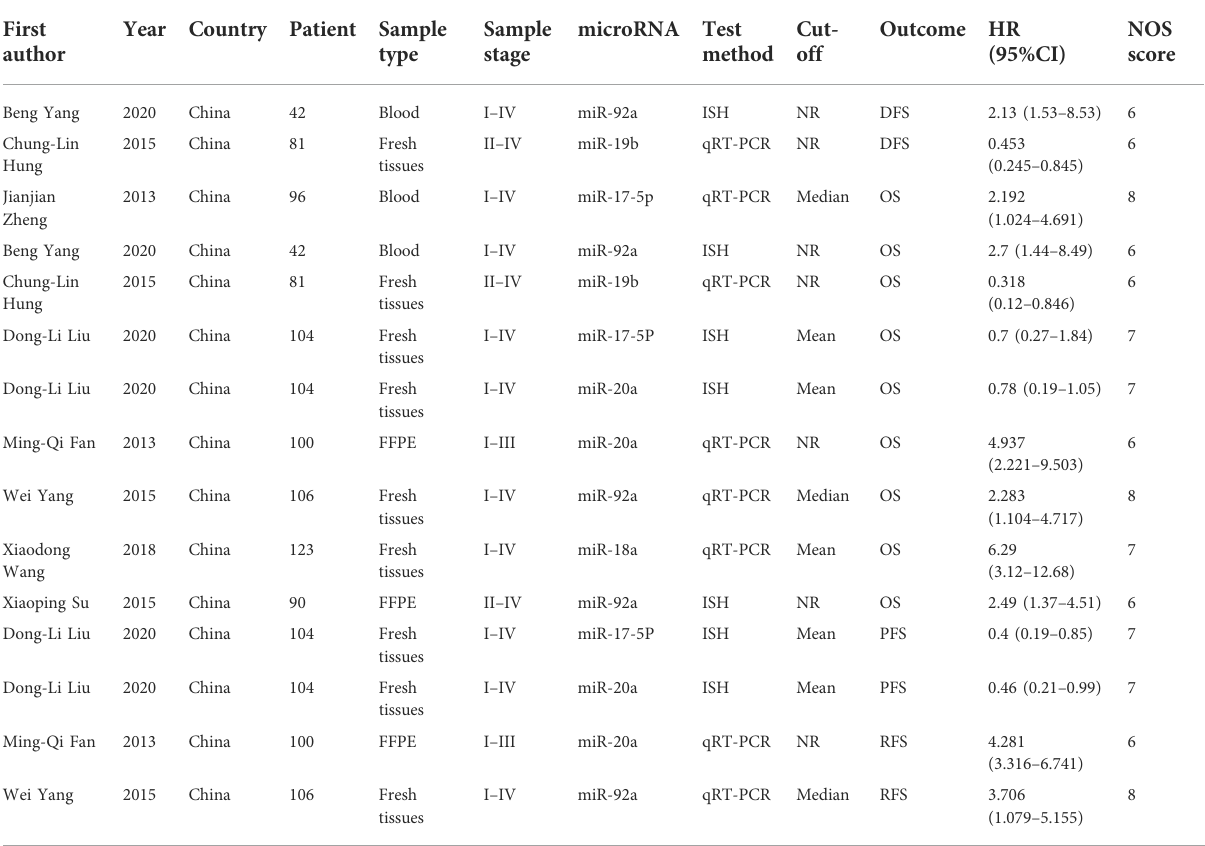
TABLE 3 Main characteristics of the eligible studies for prognostic